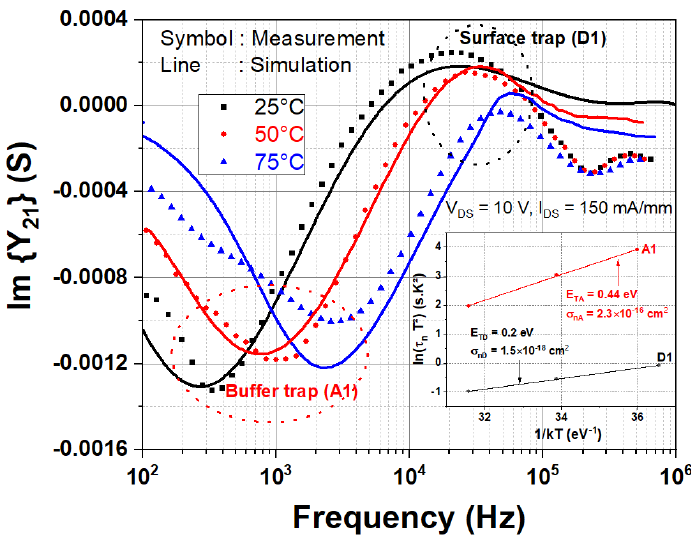
Figure 15. The simulated and measured LF Y 21 parameters at V DS = 10 V, I DS = 150 mA/mm for dif- ferent temperatures (25 to 75 °C) indicate two traps: A1 at E C –0.44 eV and D1 at E C –0.2 eV. The simulation analysis reveals that trap D1 corresponds to the surface donor